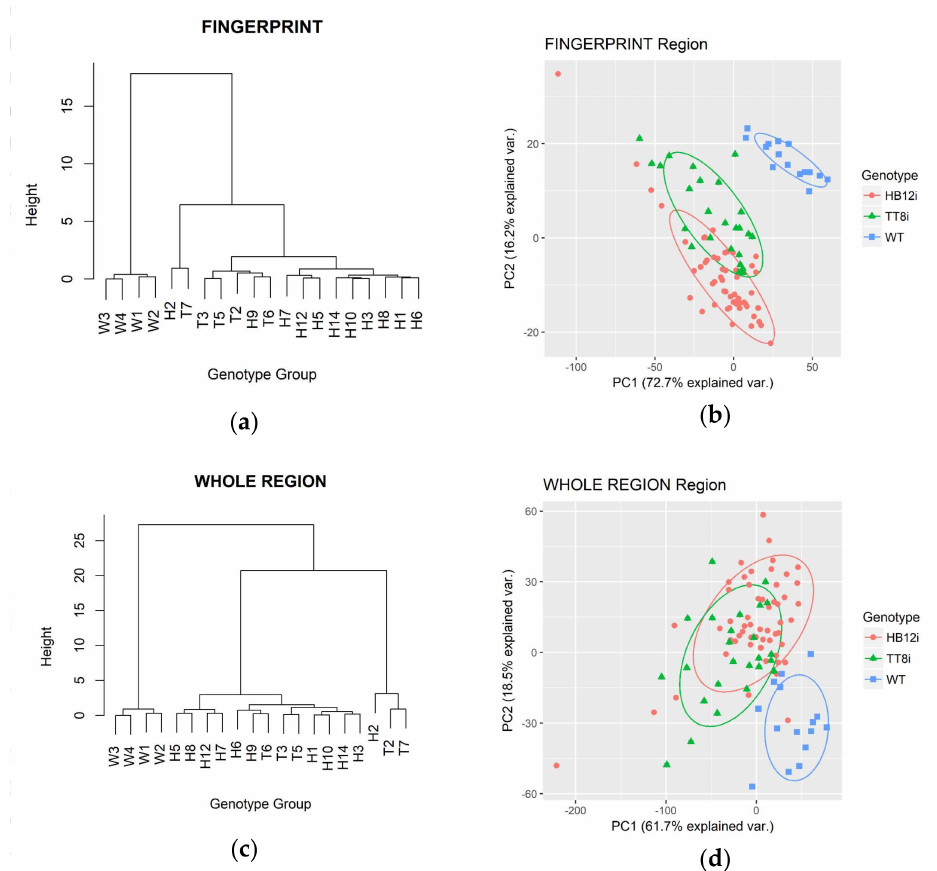
Figure 4. Hierarchy cluster analysis (HCA) dendrograms and principle component analysis (PCA) plots of whole region and fingerprint region of transgenic (H1–H3, H5–H10, H12, H14; T2–T3, T5–T7) and WT (W1–W4) control. Baseline of fingerprint region and whole region are ca. 1800–800 cm − 1 and ca. 4000–700 cm − 1 , respectively. ( a ) HCA dendrogram of fingerprint region; ( b ) PCA plot of fingerprint region; ( c ) HCA dendrogram of whole FTIR region; ( d ) PCA plot of whole FTIR